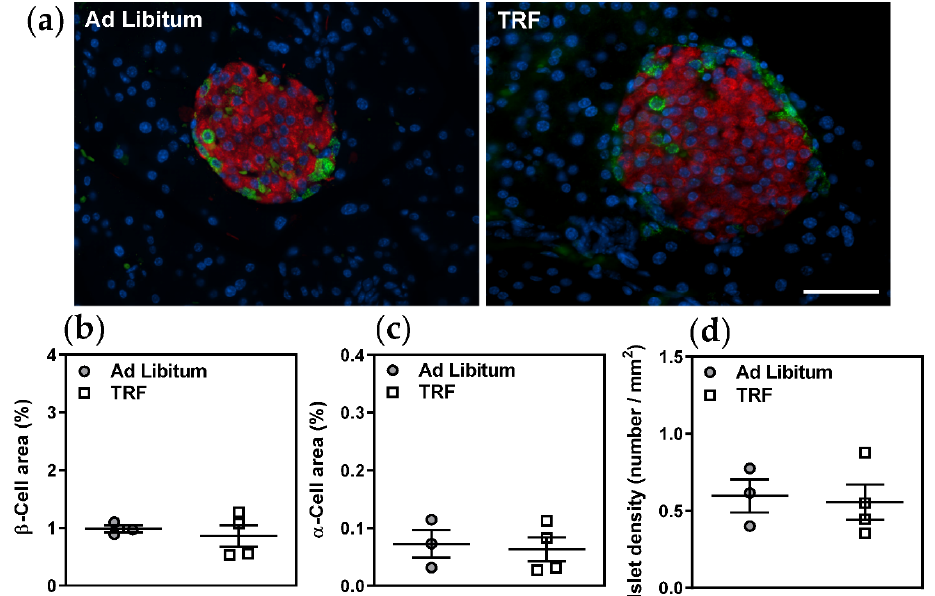
Figure 6. Two-week TRF does not alter pancreatic islet architecture in obese mice. ( a ) β-cells and α-cells were visualized by immunofluorescent staining for insulin (red) and glucagon (green), respectively. Nuclei were counterstained with DAPI (blue). ( b , c ) β-cell and α-cell areas were determined per total pancreas areas. ( d ) Islet densities were determined per total tissue area. Scale bar represents 50 µm. Data are means ± SEM, n = 3–4.